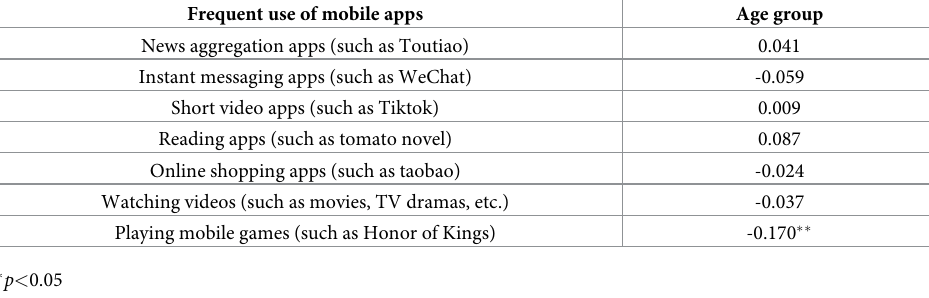
Table 7. Pearson Correlation Coefficient between the age of pilots and their frequent use of mobile apps. Frequent use of mobile apps Age group News aggregation apps (such as Toutiao)